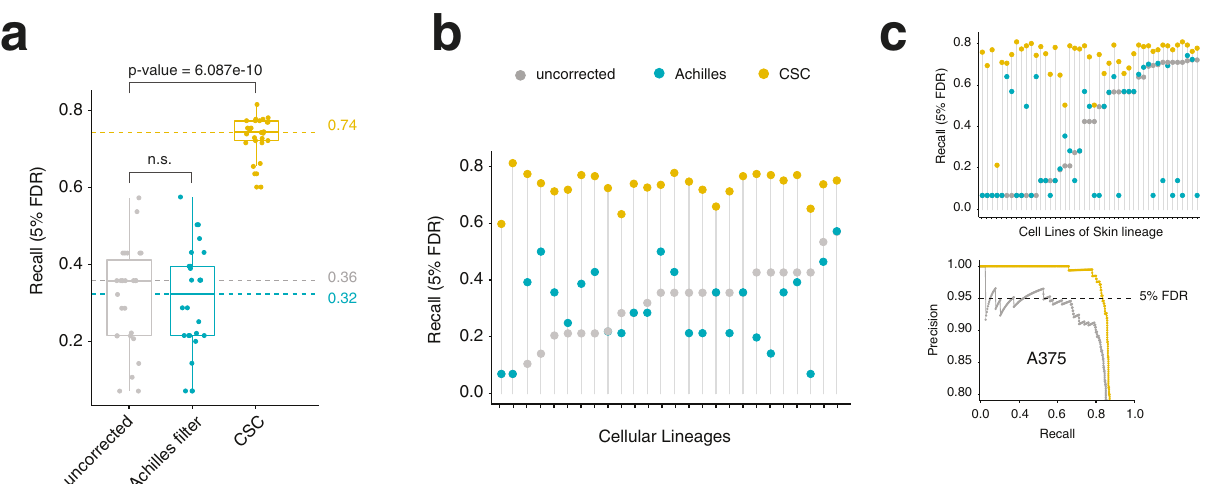
Fig. 3 CSC improves the performance of CRISPR-Cas9 essentiality screens. a Boxplot showing recall values at 5% FDR for the 19Q4 Project Achilles dataset ( n = 689) before correction (grey), with the Achilles fi lter (blue), or with the CSC correction (yellow). Each dot represents the median recall value of a lineage ( n = 26). Minimum, maximum, median, fi rst, and third quartiles are shown. p -values were calculated using a two-sided Wilcoxon test. b Median recall values at 5% FDR for each lineage. c Top, example plot for a single lineage (skin). Bottom, example precision-recall plot for a single cell line (A375 melanoma cells). Lollipop graphs are plotted by increasing values of the uncorrected pipeline. The maximum recall value at 5% FDR was used for each